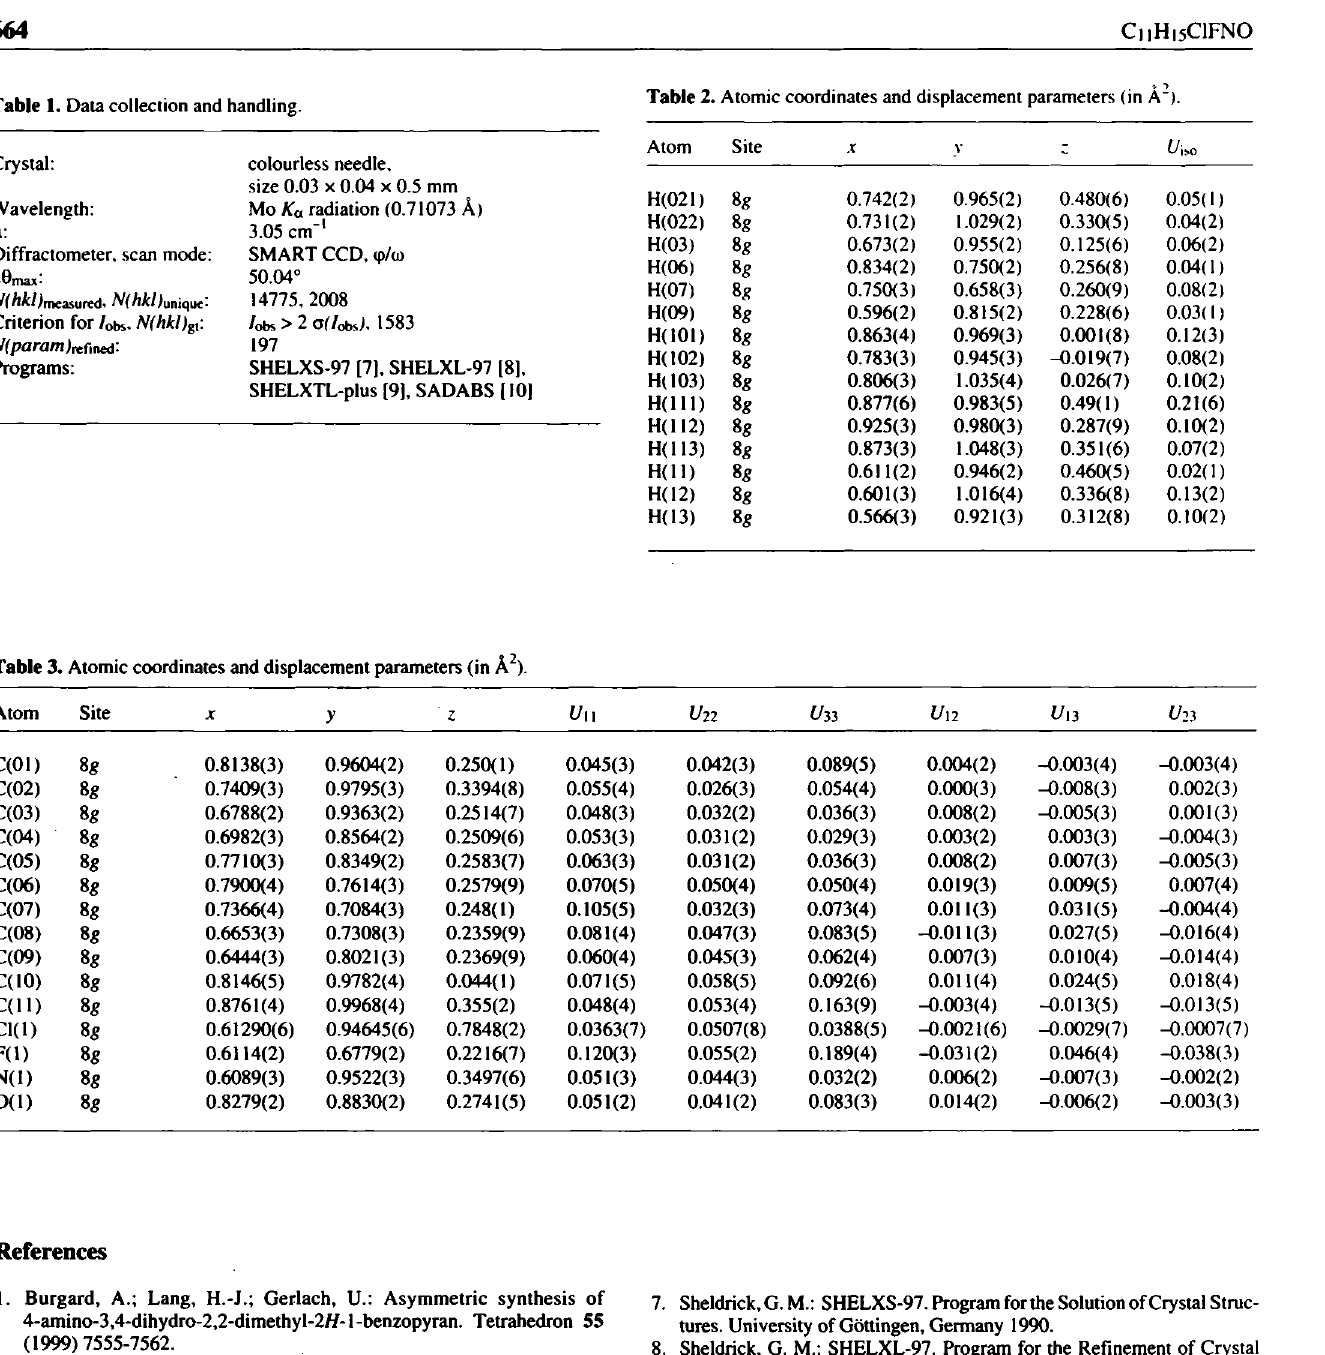
Table 1. Data collection and handling. Table 2. Atomic coordinates and displacement parameters (in A~).